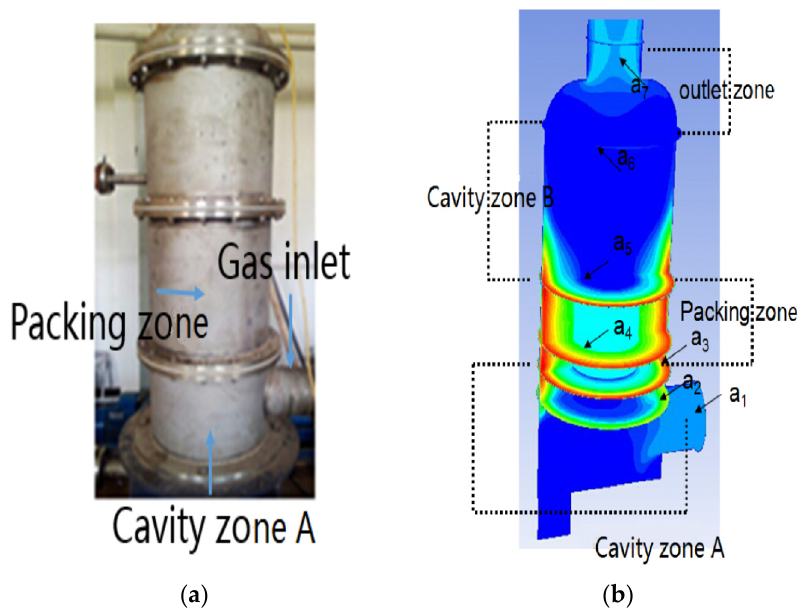
Figure 1. The physical diagram and CFD model of cross-flow RPB. ( a ) Physical diagram; ( b ) CFD model. Table 1. The characteristic parameters of the cross-flow RPB.